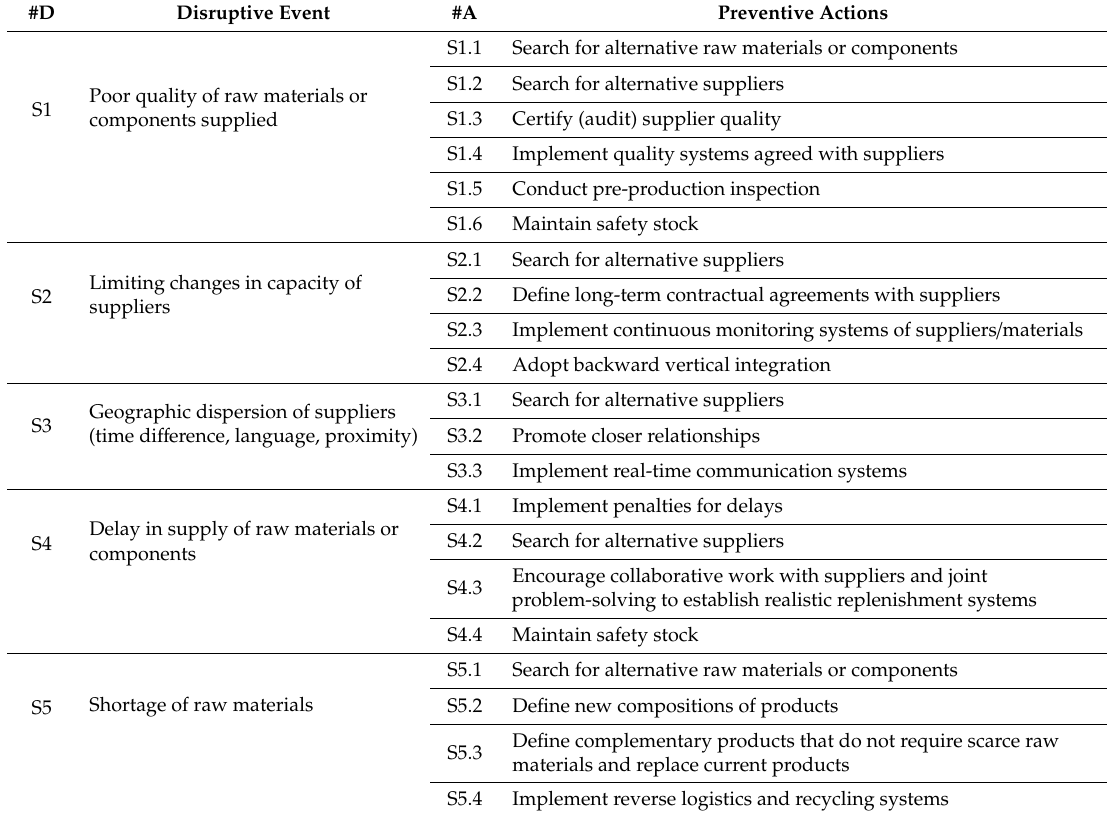
Table 6. Summary of disruptive events related to supply aspects and preventive actions (based on